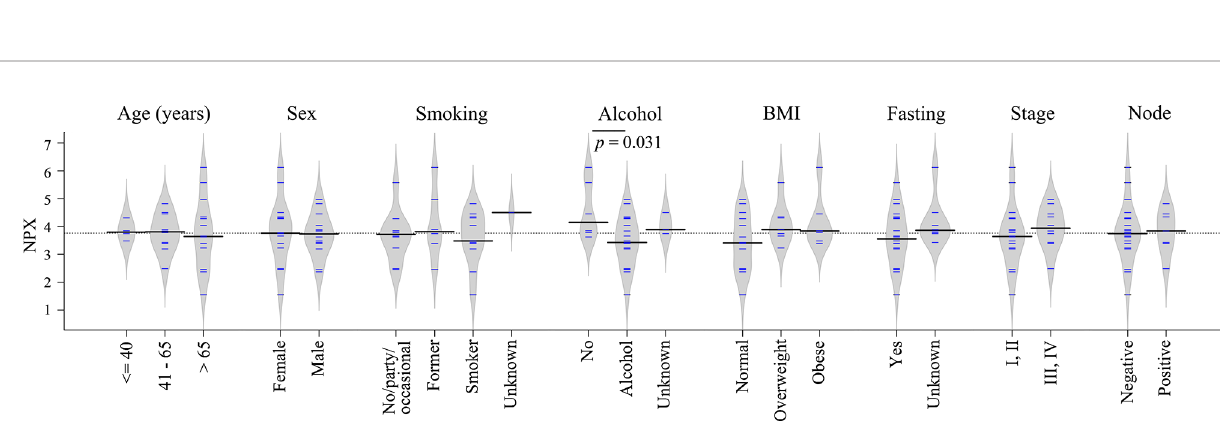
FIGURE 6 | Bean plots showing TRAF2 levels in patients with different clinical features. The grey area shows the estimated density of distribution. The horizontal lines within the grey area show individual observations, while the black line is the